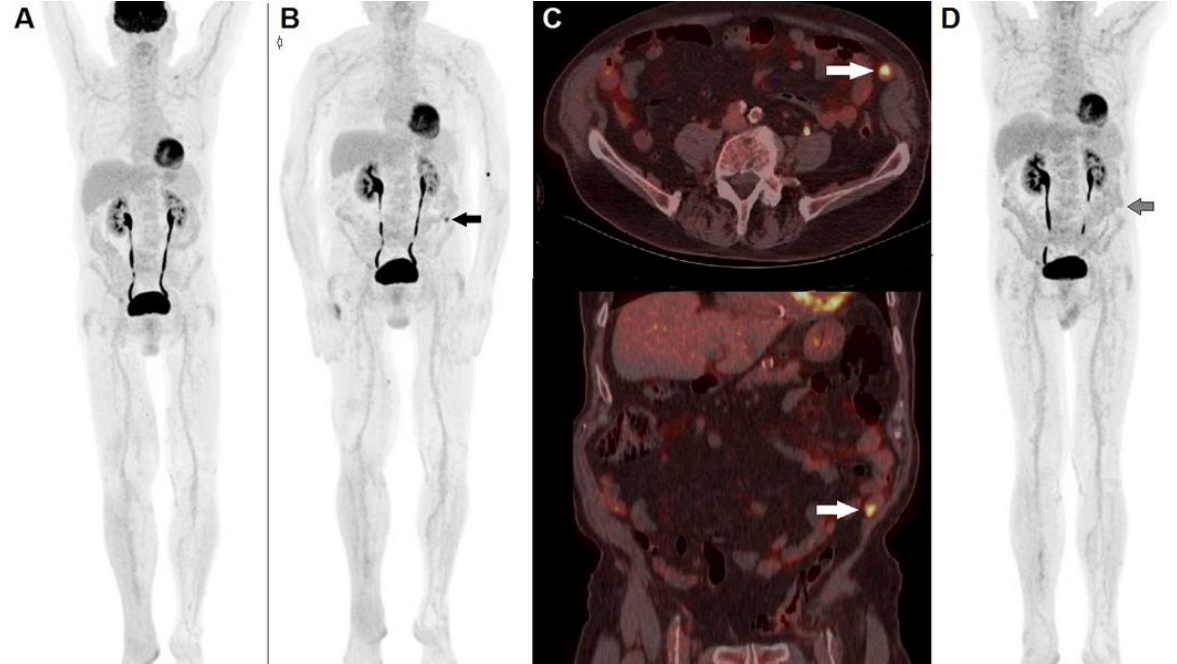
Figure 2. A 74-year-old male, previously submitted to excision of nodular cutaneous melanoma of the right foot (Breslow thickness of 8 mm, Clark level IV, stage pT4a), performed 18 F-FDG PET/CT before the start adjuvant immunotherapy. ( A ) MIP image showed physiological tracer biodistribution, with no evidence of pathological accumulation. PET/CT MIP ( B ) performed after 3 months of PD-1 blocker (nivolumab) depicted the appearance of an area of increased tracer accumulation in the left iliac fossa (black arrow). ( C ) Fused corresponding PET/CT axial (upper row) and coronal (lower row) of the abdominal region demonstrated the onset of a hypermetabolic nodule next to the abdominal wall, suspected to be peritoneal localization (white arrow). The pattern was interpreted according to PERCIMT criteria (i.e., pseudo-progression) and the patient continued immune check-point inhibitor. A further PET/CT MIP ( D ) after 6 weeks demonstrated complete spontaneous regression of the area of increased 18 F-FDG accumulation in the left iliac fossa (black arrow), thus confirming the diagnosis of